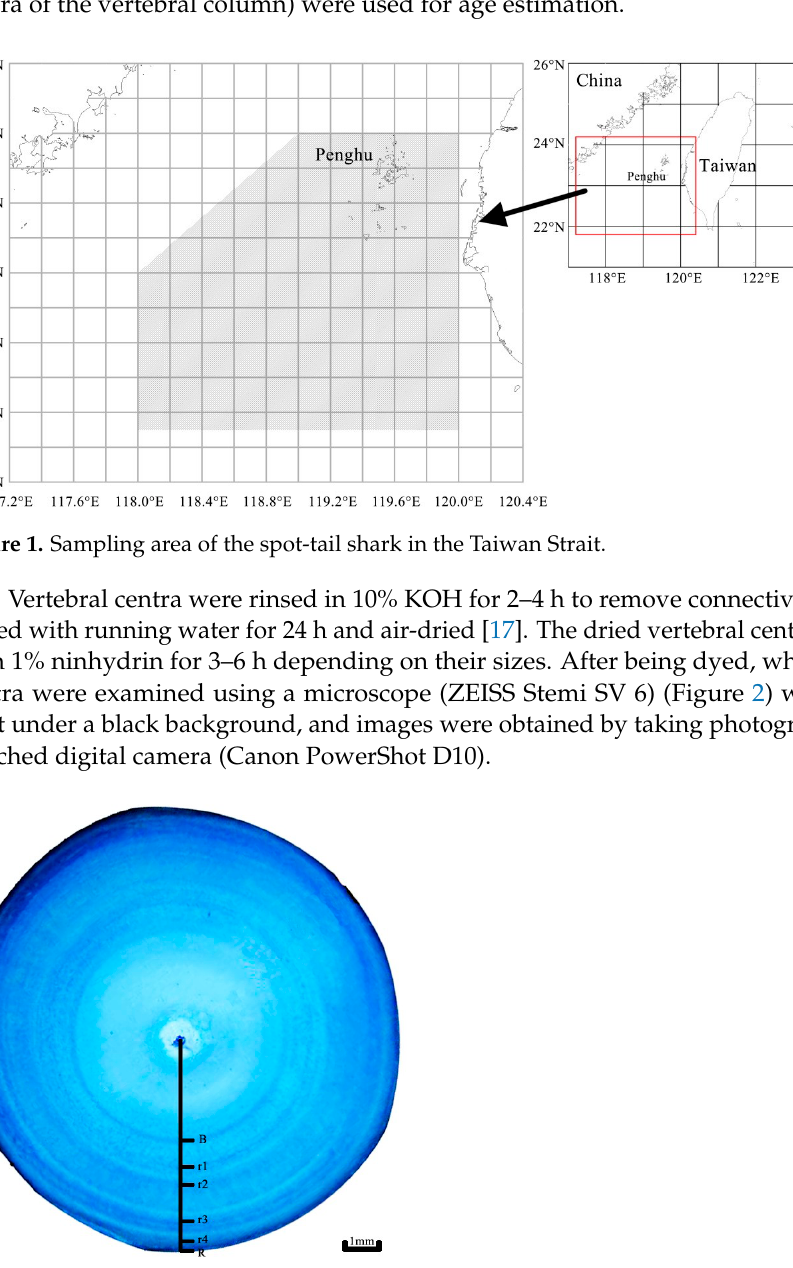
Figure 2. Longitudinal cross section of a vertebral centrum from a female spot-tail shark (117 cm TL) counted to be 4 band pairs. B: birth mark; R: centrum radius.